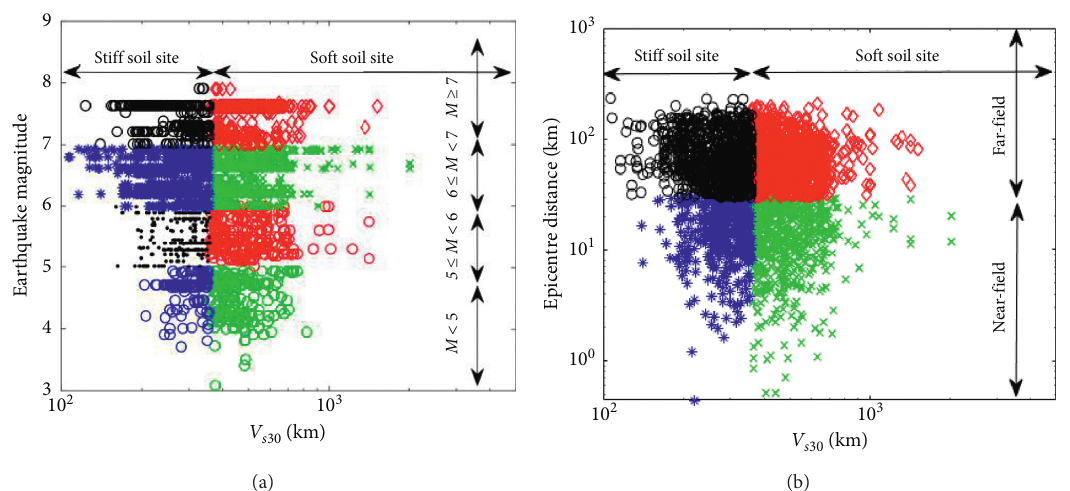
Figure 8: (a) Earthquake magnitude- V s 30 distribution and (b) epicentre distance- V s 30 distribution in different site classifications.